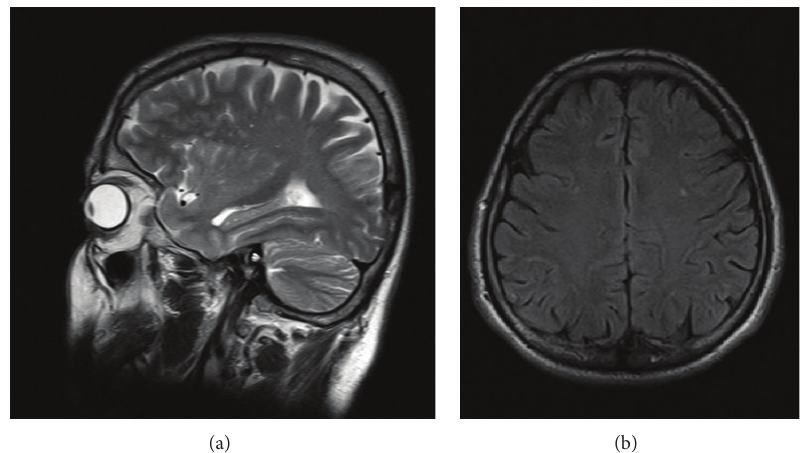
Figure 2: (a) T2-weighted sagittal and (b) axial flair images revealed the presence of small hyperintense pericallosal lesions and supraventricular white matter